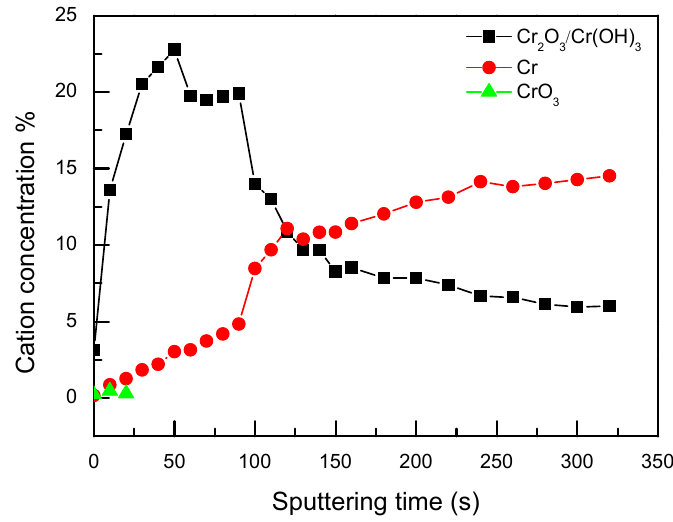
Figure 9. XPS sputtering depth profiles of the oxides in the passive film of S32750 after 24 d of exposure in the simulated marine atmosphere. (a)